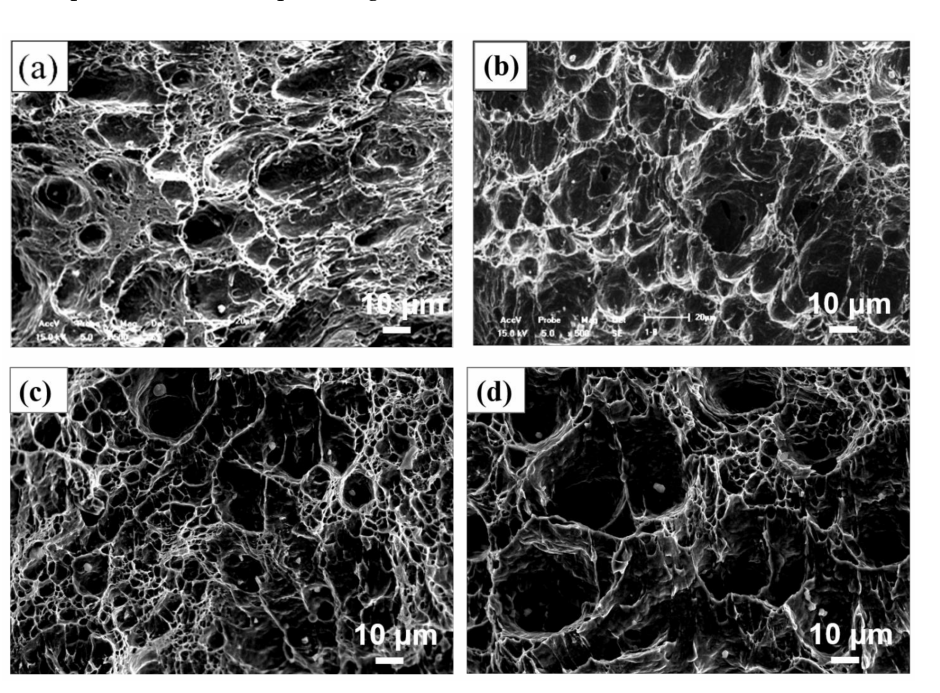
Figure 9. SEM fracture surfaces of steels under different welding processes. ( a , b ) No.1 steel under W1 and W2 welding process, ( c , d ) No.2 steel under W1 and W2 welding